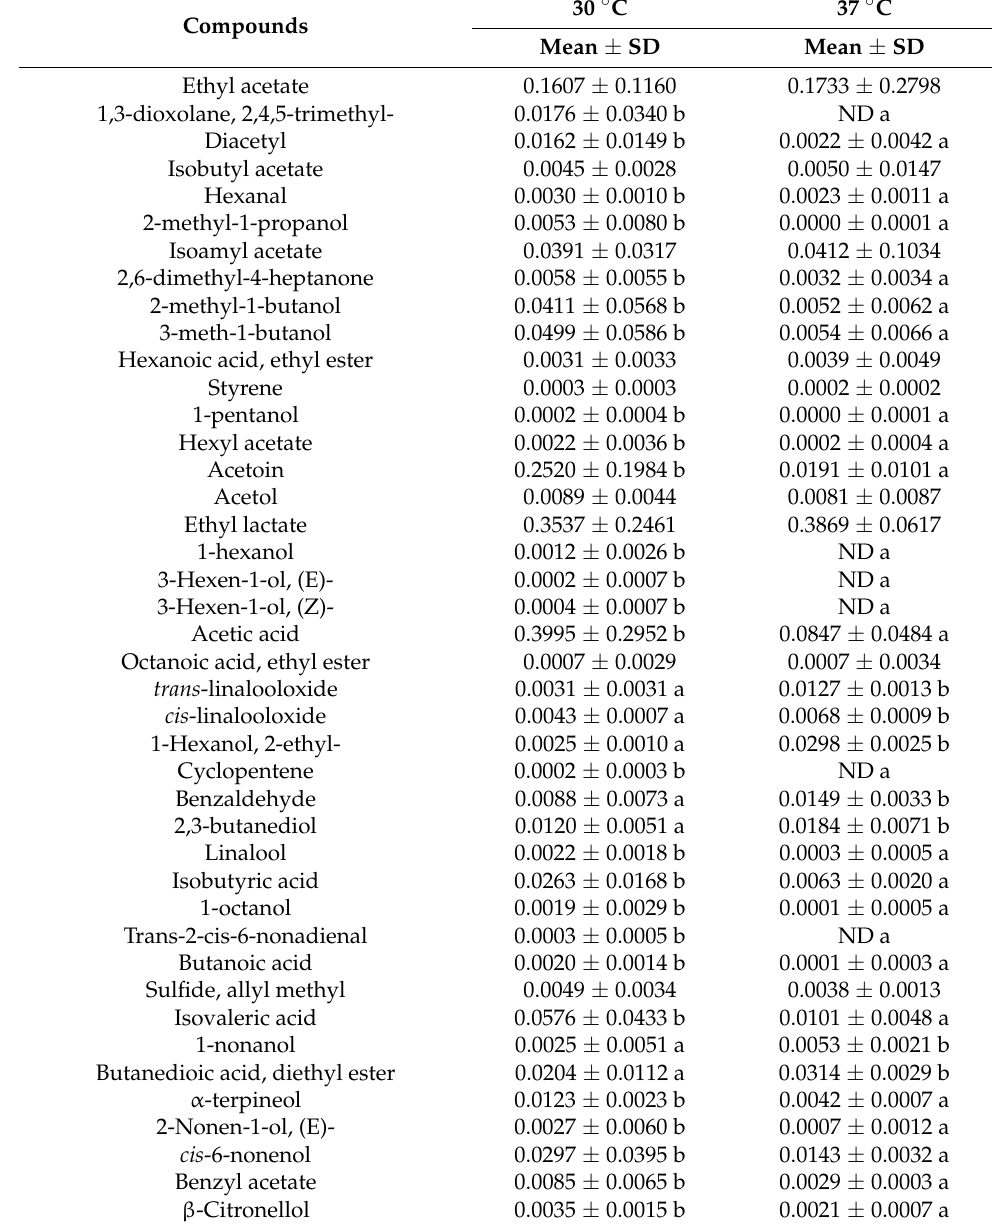
Table 3. Mean relative areas and standard deviations of volatile identified by SBSE-GC-MS in Prickly pear Vinegar produced by surface culture method at 30 ◦ C and 37 ◦